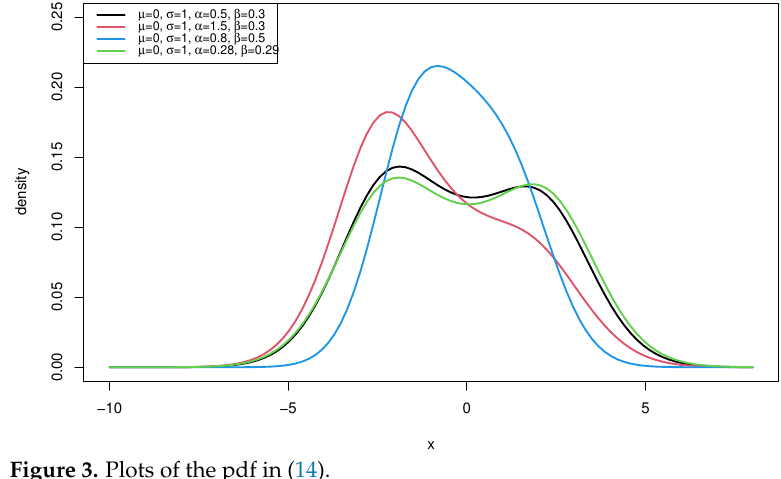
Figure 3. Plots of the pdf in